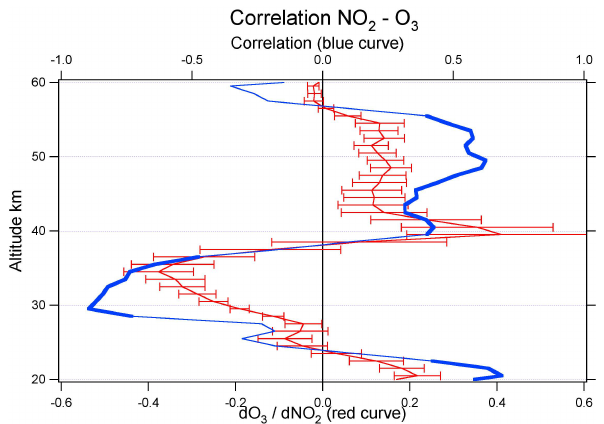
Fig. 5. Correlation between the deviations of NO 2 and O 3 from their mean value for the full period at the given altitude (blue curve, values larger than ± 1 standard deviation uncertainty are represented with a thick line) and relative deviation of O 3 per unit of relative deviation of NO 2 (red curve, the 1-sigma uncertainty is plotted).